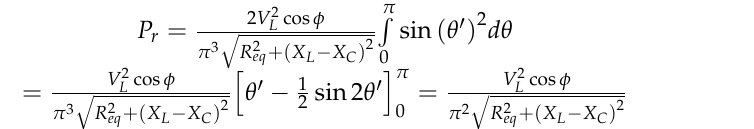
Equation (22) is integrated to find the average power delivered by the rectifier at